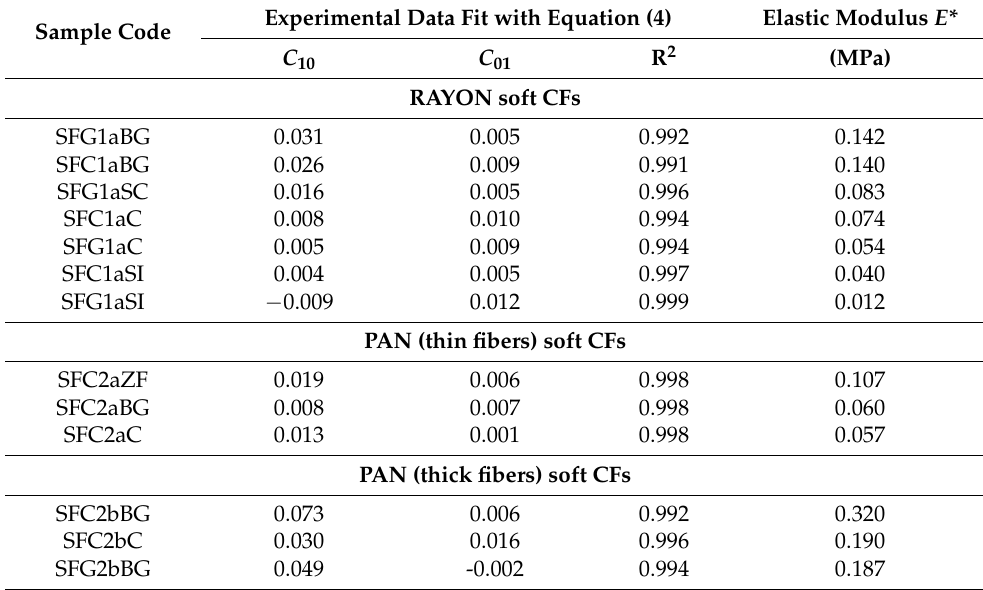
Table 2. Mooney-Rivlin constants identified from fitting Equation (4) to the experimental data and values of the elastic modulus, E *, obtained by application of Equations (5) and